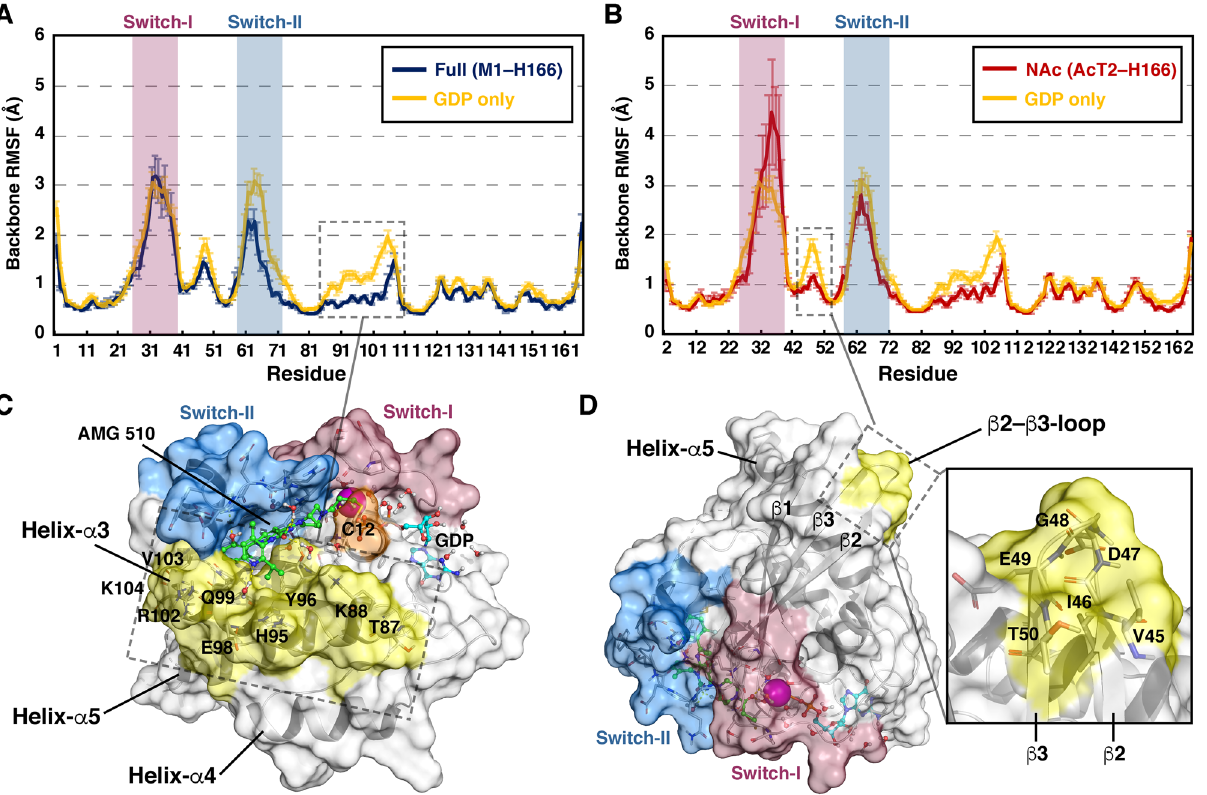
Figure 3. Root-mean-square fluctuations (RMSF) of protein backbone. ( A ) RMSF of full M1–H166 systems (50 μs simulation data). ( B ) RMSF of NAc (AcT2–H166) systems (25 μs simulation data). The ‘GDP only’ RMSF data in A and B is taken from previously published 70 μs KRAS–GDP simulations 2 . Error bars represent standard error. ( C ) Lower RMSF values are observed in both systems for the Helix-α3, which location and residues are highlighted in yellow (PDB ID: 6oim). ( D ) Lower RMSF values are observed with NAc systems for the β2–β3-loop, which location and residues are highlighted in yellow (PDB ID: